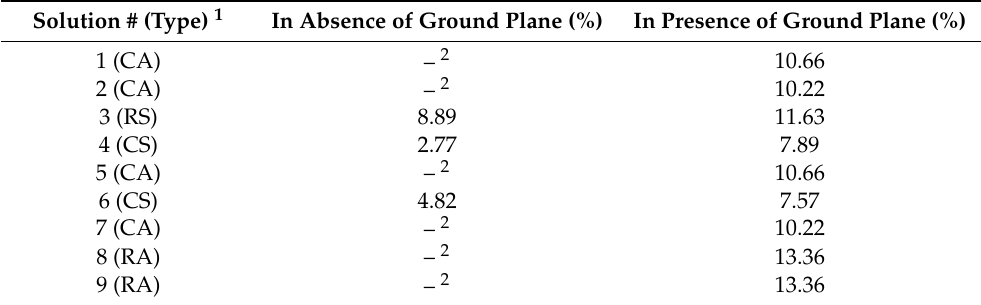
Table 4. Maximum rate of change among the elements of the resonant linear array structure in comparison with the half-wavelength design for the Real Pattern Case (RPC) of 12 elements.